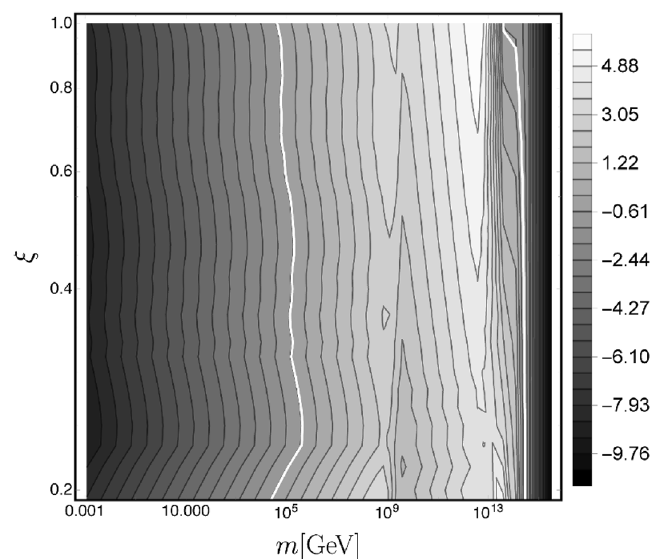
Figure 8 . We represent the predicted abundance for the scalar (cid:12)eld in logarithmic scale, i.e., the contours of log (cid:10) considering the maximum allowed reheating temperature, T rh = 10 15 GeV. The 10 white contours represents the observed abundance of dark matter (cid:10) DM = 0 : 268. The allowed